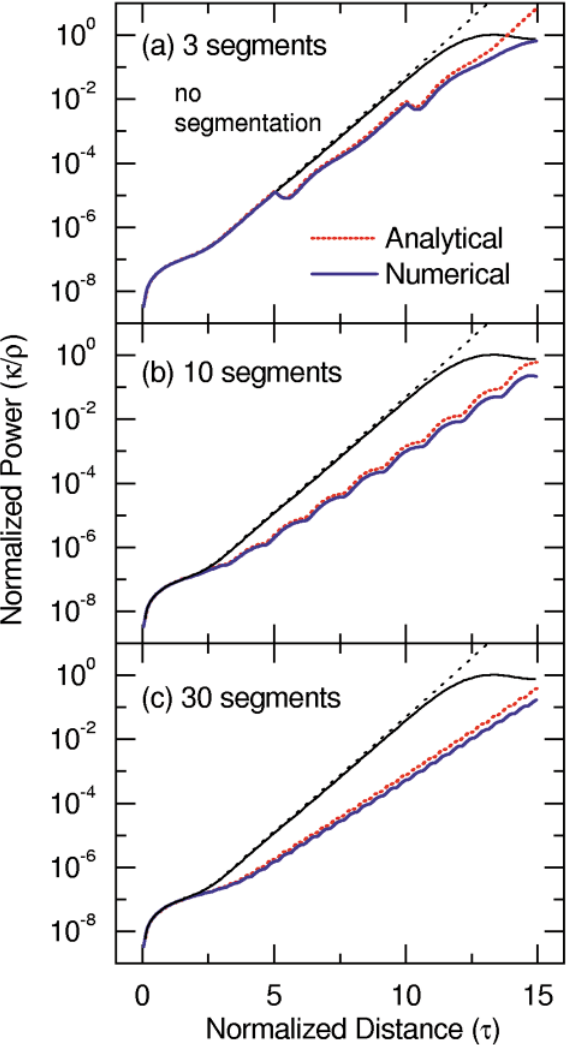
FIG. 2. (Color) Normalized power k (cid:1) r versus the normalized distance t in the optical cutoff case for different numbers of segments: (a) 3 segments, (b) 10 segments, and (c) 30 segments. The discontinuity corresponds to the drift section. In each figure, the no-segmentation case is also shown for comparison.